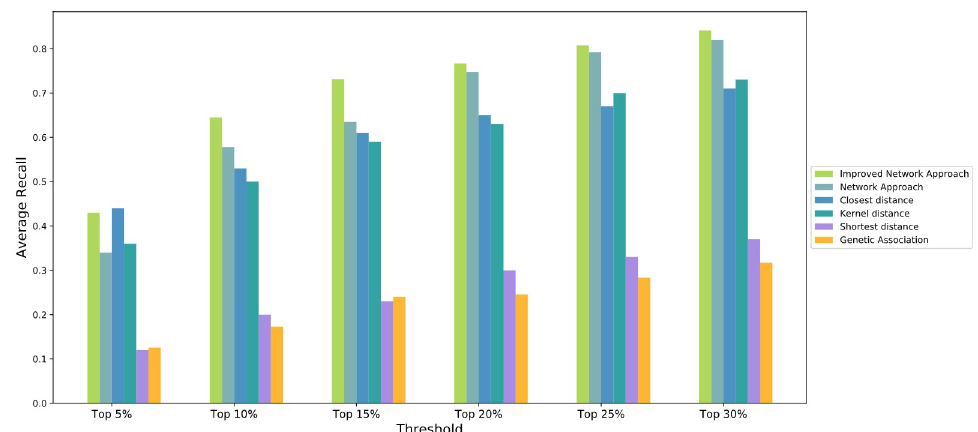
Fig 5. Sensitivity of predictions on network approach and other